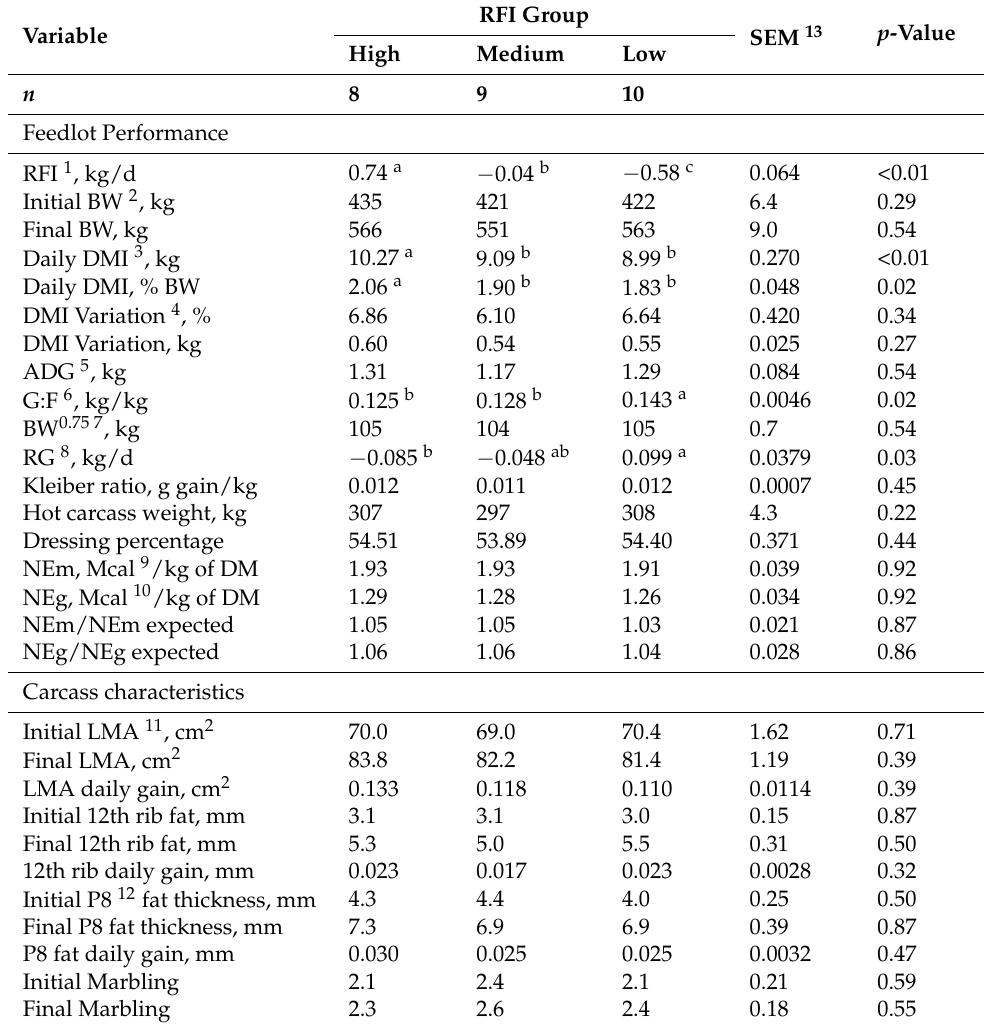
Table 2. Feedlot performance and carcass characteristics of Nellore bulls consuming high concentrate diets classified by residual feed intake